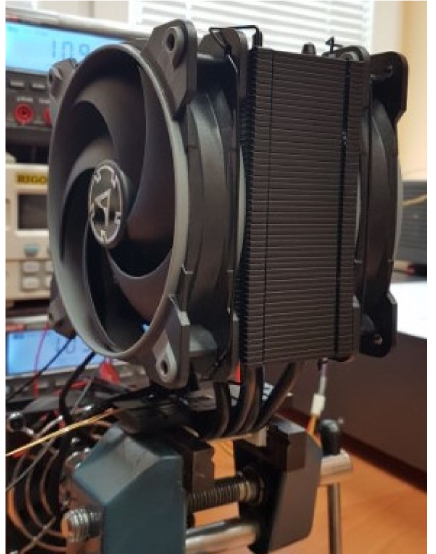
Figure 4. General view of cooling systems with the Arctic Freezer 34 eSports Duo.